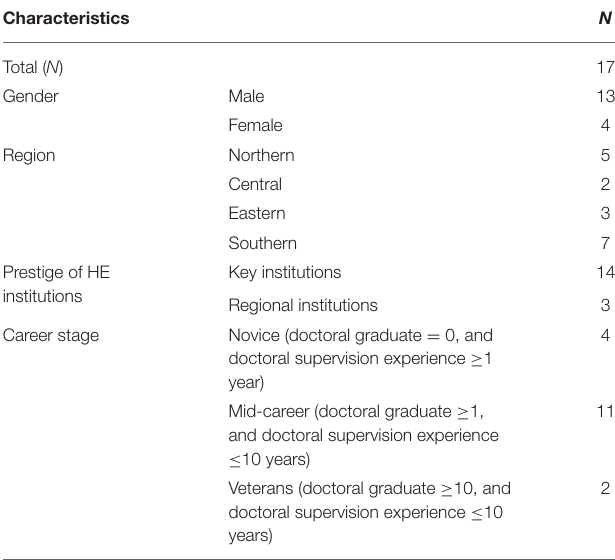
TABLE 2 | Demographic characteristics of the